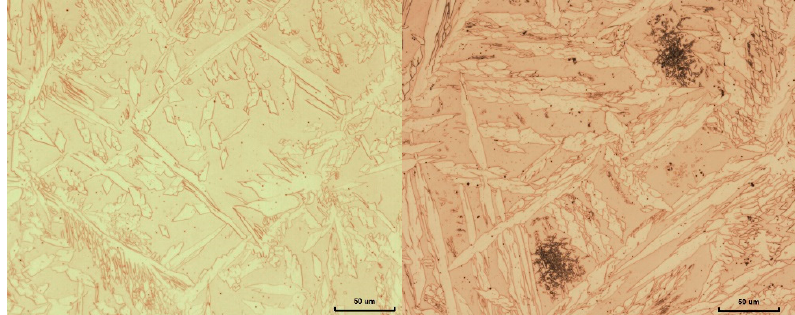
Figure 9. Micrographs of Weld Pass 1 in the GH weld. ( Left ) As-deposited. It shows Widmanstätten austenite laths within the ferritic matrix. ( Right ) After six reheating cycles. Widmanstätten austenite laths grew (an average of 4 μ m thicker) and secondary austenite (small needle-shaped) was formed in the intragranular areas of the ferritic matrix.